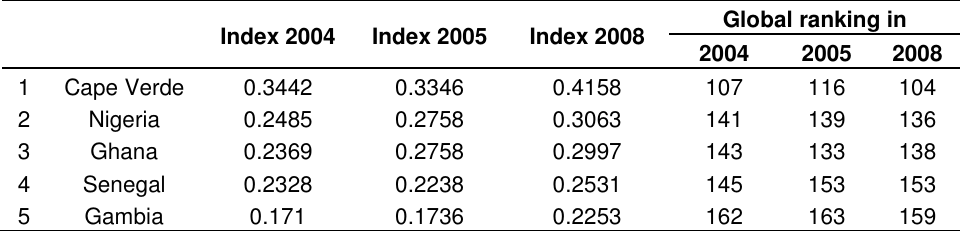
Table 1. West African countries e-government readiness index 2004/2005/2008.